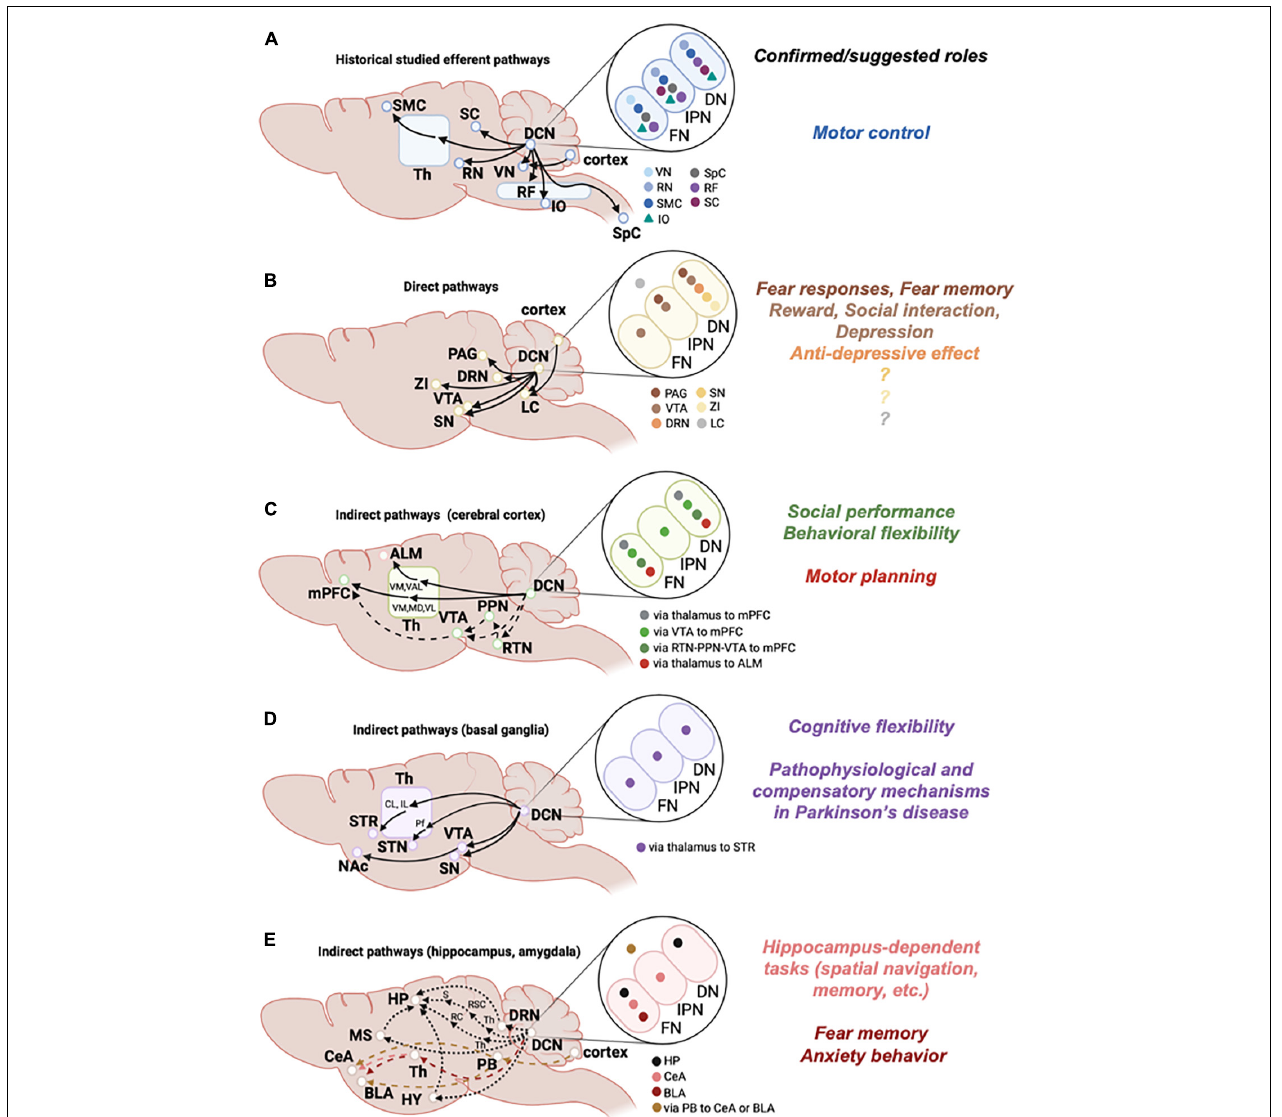
FIGURE 1 | Efferent pathways from the cerebellum. Left: Schematic diagrams of historically studied efferent pathways related to motor functions (A) , and of direct (B) or indirect (C,D) efferent pathways that are considered to be associated with non-motor functions. Indirect pathways are further categorized according to the target brain regions, i.e., cortex (C) , basal ganglia (D) , and hippocampus or amygdala (E) . Solid lines are pathways that were experimentally confirmed, and dashed lines are pathways that were suggested. Brain regions written in small size of letters in E are positioned independent of the actual locations in the brain. Middle: Target brain regions that each DCN subregion connects with are shown by color-coded symbols (e.g., in A, light blue symbol is shown in the FN, but not in the IPN or DN, indicating that the vestibular nucleus (VN) receives connections from the FN, but not from the IPN or DN). Note that DCN subregions projecting to the LC (B) and to the amygdala via PB (E) are not determined, so that these symbols are shown outside of ellipses showing DCN subregions. Right: Functions of pathways that are experimentally demonstrated or suggested are summarized. Colors correspond to the pathways of target brain regions shown in the middle. Th, thalamus; RF, reticular formation; SMC, sensorimotor cortex; SpC, spinal cord; ZI, zona incerta; RTN, reticulotegmental nuclei; PPN, pedunculopontine tegmental nuclei; VM, ventromedial thalamus; MD, mediodorsal thalamus; VAL, ventral anterior lateral thalamus; VL, ventrolateral thalamus; STR, striatum; CL, centrolateral thalamus; IL, intralaminar thalamus; Pf, parafascicular thalamus; HP, hippocampus; HY, hypothalamus; MS, medial septum; RC, rhinal cortex; RSC, retrosplenial cortex; S, subiculum; PB, parabrachial nucleus; CeA, central amygdala; BLA, basolateral amygdala. See text for other